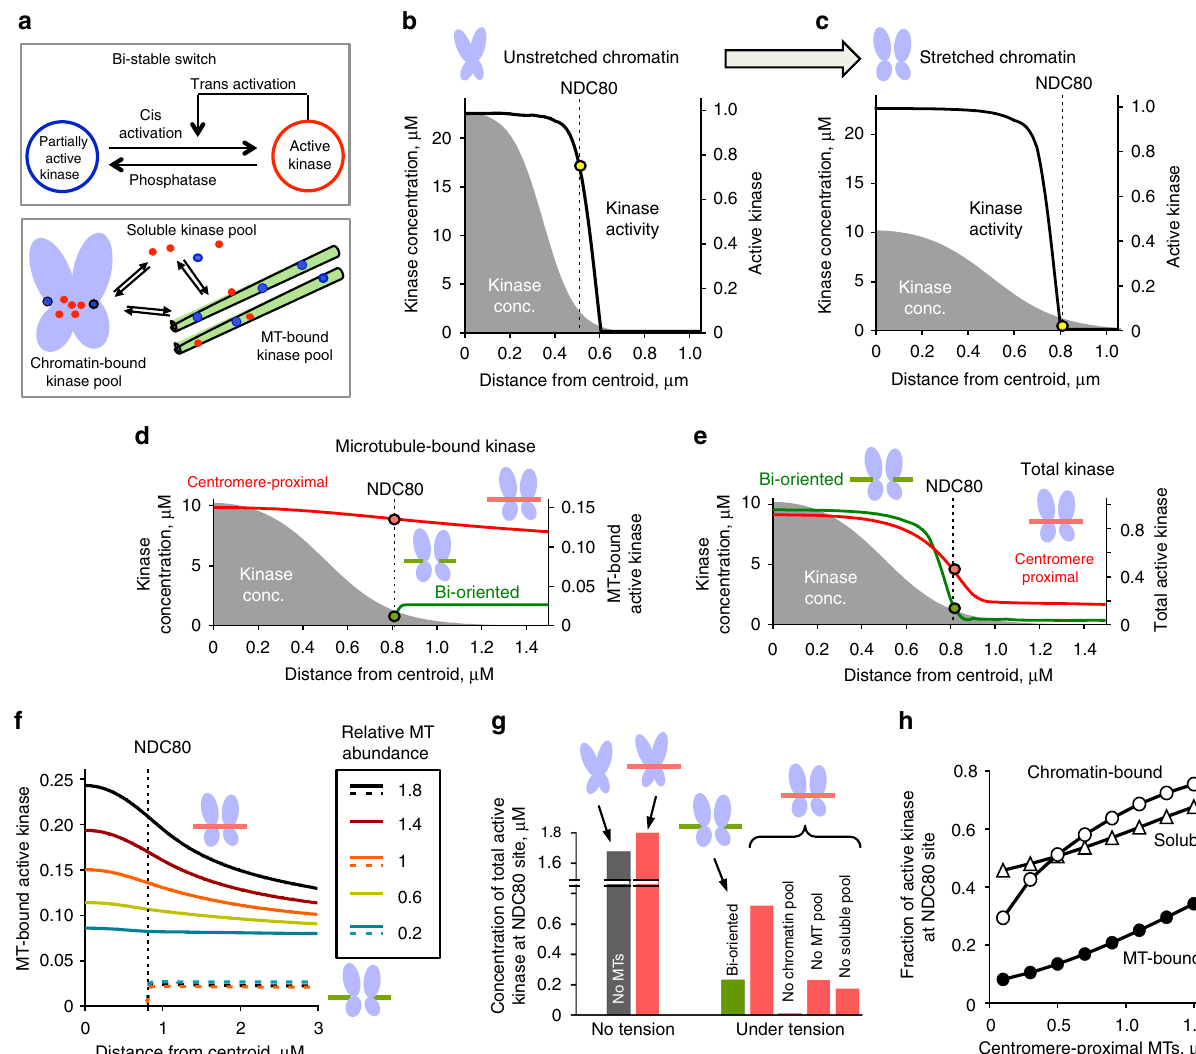
Fig. 4 Mathematical model of tension-dependent and microtubule con fi guration-dependent phosphoregulation at kinetochores. a Upper box: schematic for kinase-phosphatase switch. Lower box: schematic for dynamically exchanging CPC pools. Kinase within each pool becomes activated by auto- phosphorylation and inactivated by soluble phosphatase, see Methods for details. Unless stated otherwise, calculations for all panels were done using model parameters listed in Supplementary Table 6 for different centromeric tension and/or microtubule con fi gurations. b , c The concentration of chromatin-bound CPC kinase (gray, left axis) decreases from the middle of the centromere (centroid) to outer kinetochore containing Ndc80 substrate (shown with broken line). Because the total amount of chromatin-bound kinase does not change under tension, when chromatin is stretched, the kinase concentration is reduced throughout the centromere. Black lines (right axes) show the fraction of chromatin-bound kinase that is active; these curves drop abruptly due to bi-stability. Yellow dots show activity of chromatin-bound kinases at the Ndc80 location. These panels show tension-dependent model (cid:1) (cid:3) behavior in the absence of the microtubule-bound kinase pool k MT . d , e Pro fi les as in c for different microtubule con fi gurations: bi-oriented (green) ¼ 0 on or with centromere-proximal microtubules (red). Left axes — concentration of chromatin-bound kinase under tension (gray). Colored curves are plotted using the right axes, showing fraction of active kinase for all CPC pools ( e ) or only for the microtubule-bound pool ( d ). Colored dots show fraction of active kinase at Ndc80 site; the corresponding concentrations for dots on panel d are plotted in panel g “ under tension ” . f Spatial distribution of active microtubule-bound kinase (fraction from the microtubule-bound kinase pool) for different microtubule abundance (parameter α ), see panel d for other details. Solid and dashed lines correspond to con fi gurations with centromere-proximal and end-on microtubules, respectively. g Calculated concentration of active kinase (sum of all pools) at Ndc80 location of the kinetochore for indicated con fi gurations. The last three columns correspond to model predictions in the presence of tension and centromere-proximal microtubules but either chromatin, microtubule or soluble CPC pools are eliminated. h Fractions of active kinase in all pools — microtubule-bound, chromatin-bound and soluble — respond to the size of centromere proximal microtubule